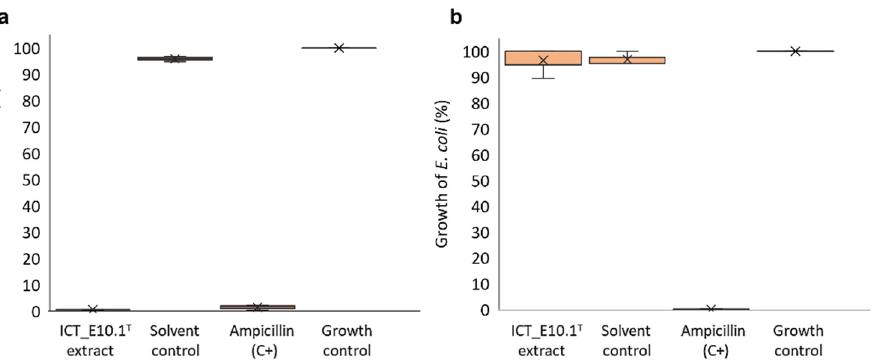
Figure 7. Boxplot diagram showing the percentage of growth of S. aureus ( a ) and E. coli ( b ) when exposed to ICT_E10.1 T extract, considering the three biologically replicated assays. The solvent control corresponds to DMSO (2% v/v final concentration in the assay), the positive control of ampicillin (4 mg/mL final concentration in the assay), and the growth control of the target bacteria without exposure to treatments. The planctomycete extract consistently inhibited the growth of S. aureus in the three assays ( a ). In contrast, very low bioactivity was observed against E. coli ( b ).